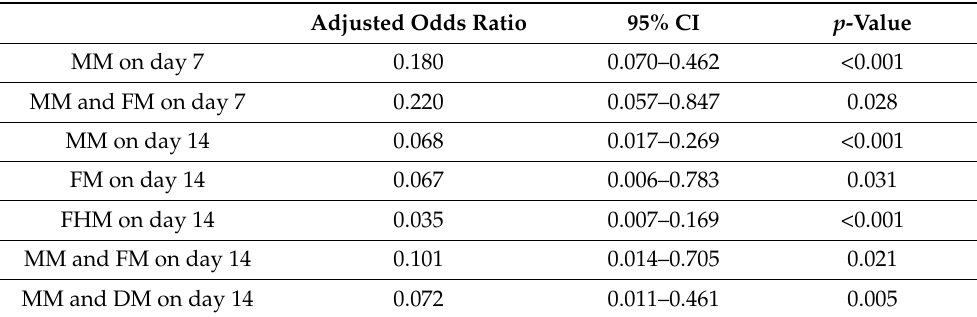
Table 7. Relationship between feeding strategies and NEC adjusted for demographic variables: results from logistic regression model on days 3, 7, and 14,